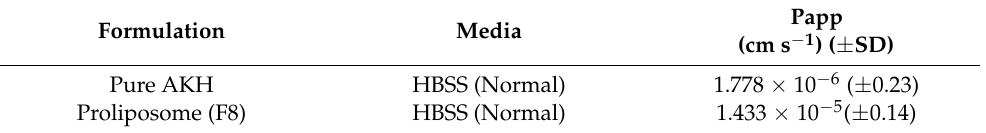
Table 9. Apparent permeability of AKH and proliposomal formulation ( n = 3).